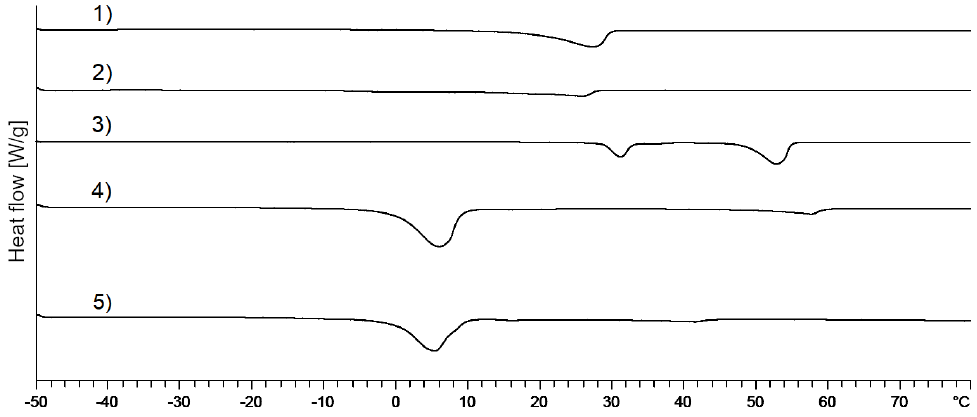
Figure 10. DSC thermograms of (1) 1,2-octanediol; (2) polysorbate 60; (3) cetostearyl alcohol; (4) mixed